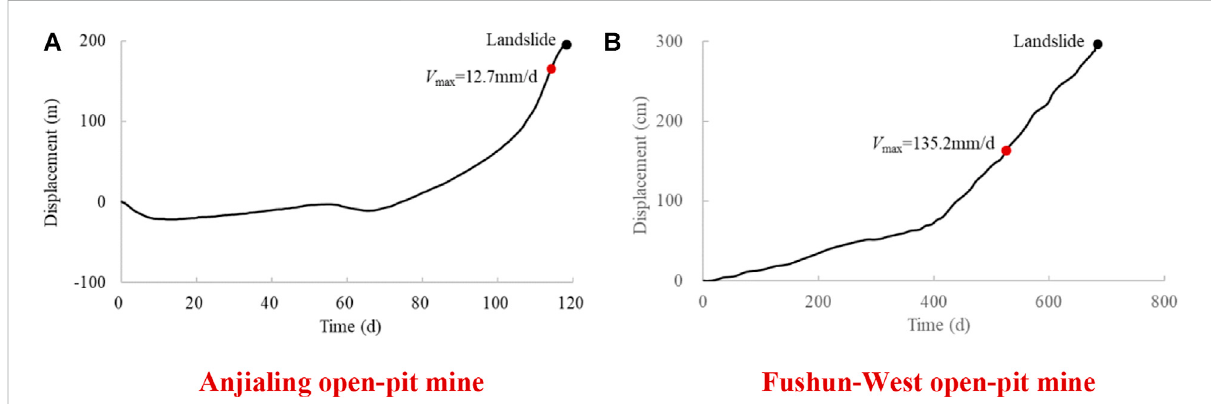
FIGURE 8 Displacement-time curves prior to the landslide at Wushan compared other similar landslide cases. (A) Anjialing open-pit mine; (B) Fushun- West open-pit mine.